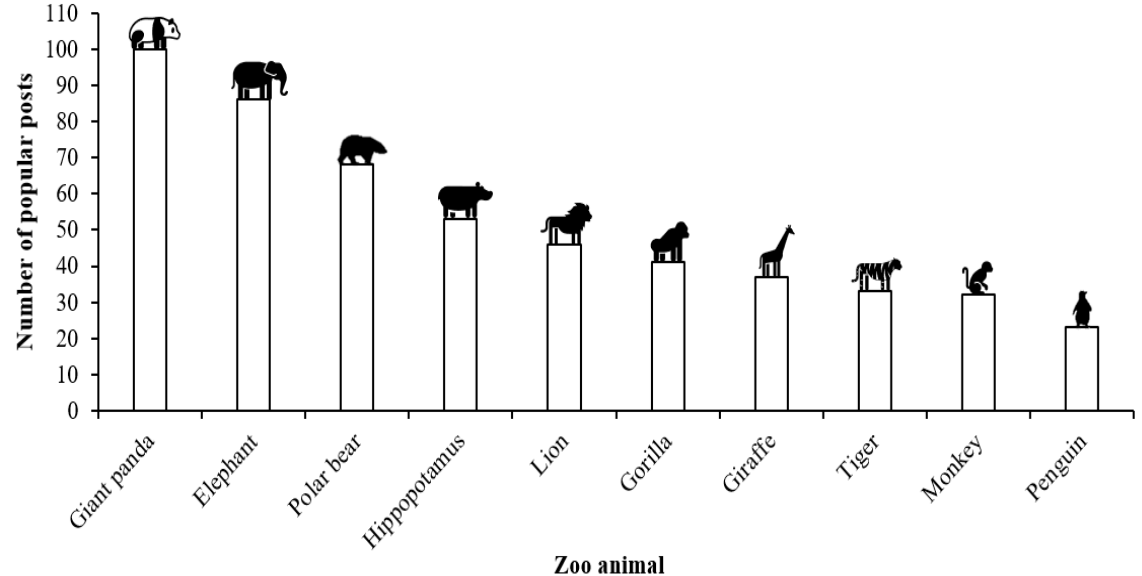
Figure 2. The ten species that featured most frequently in the most viewed (and therefore most popular in this sample) videos across all 20 YouTube channels: Giant panda (100 posts), African and Asian elephant (86 posts), polar bear (68 posts), common and pygmy hippopotamus (53 posts), lion (46 posts), gorilla (41 posts), giraffe (37 posts), tiger (33 posts), monkey (32 posts) and penguin (23 posts).